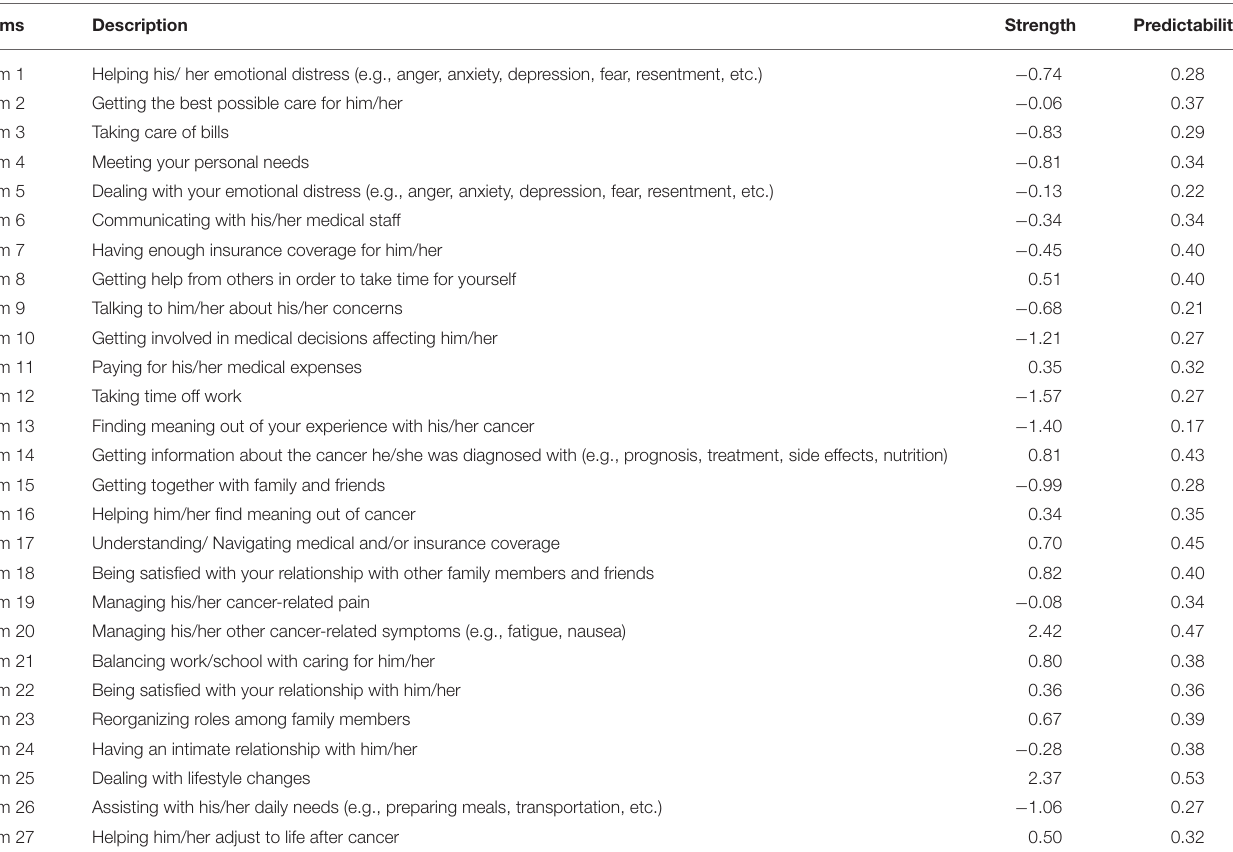
TABLE 2 | NAFC network